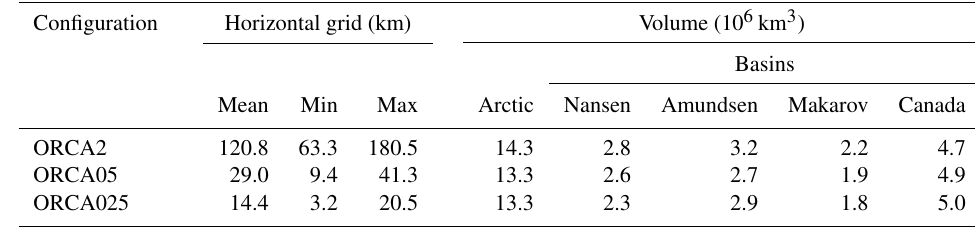
Table 1. Grid size in the Arctic Ocean and volumes by basin as a function of model resolution.